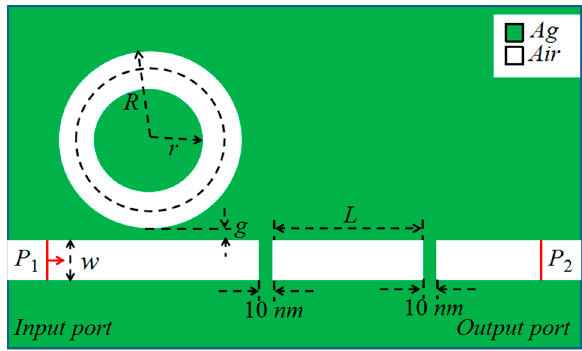
Figure 1. Schematic diagram of the plasmonic waveguide coupling structure.